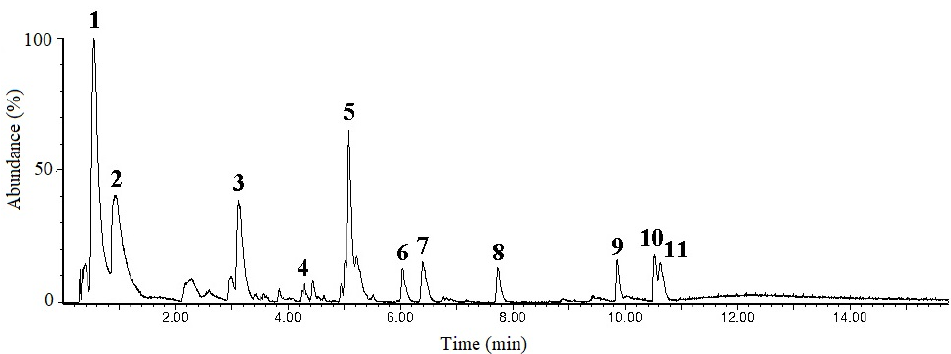
5 of 19 Figure 2. HSQC-DEPT correlation map of P-EA fraction in D 2 O at 70 °C, the chemical shifts are expressed as δ (ppm). Inverted signals in DEPT experiment are marked with *. 2.2. Secondary Metabolites of L. styraciflua Extracts